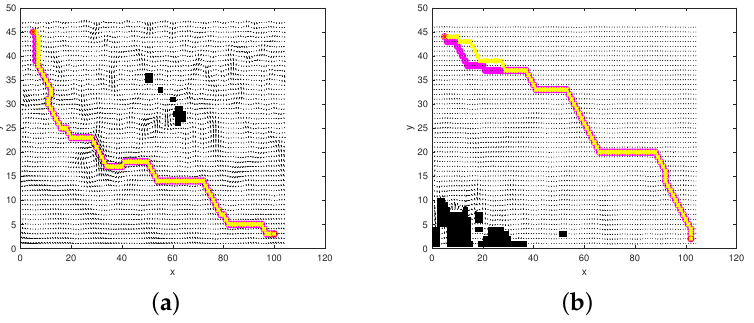
Figure 9. The paths established by two algorithms in the second type of grid maps. ( a ) The paths from (100,3) to (5,45) established by the improved A* algorithm and neural network model in 47 × 104 map. ( b ) The paths from (102,2) to (5,44) established by the improved A* algorithm and neural network model in 46 × 104 map.